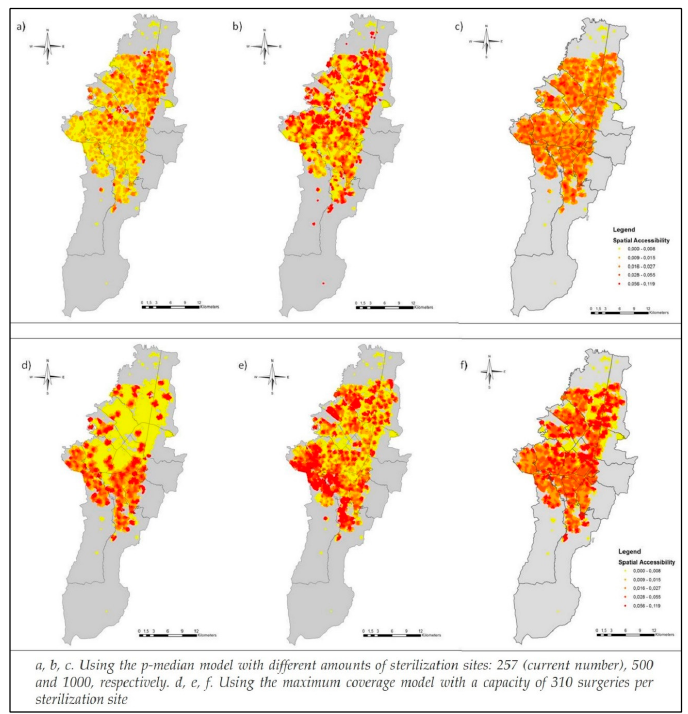
Figure 13. Spatial accessibility to sterilization sites arising from the location–allocation models in Bogota, Colombia. (Source: [90]).